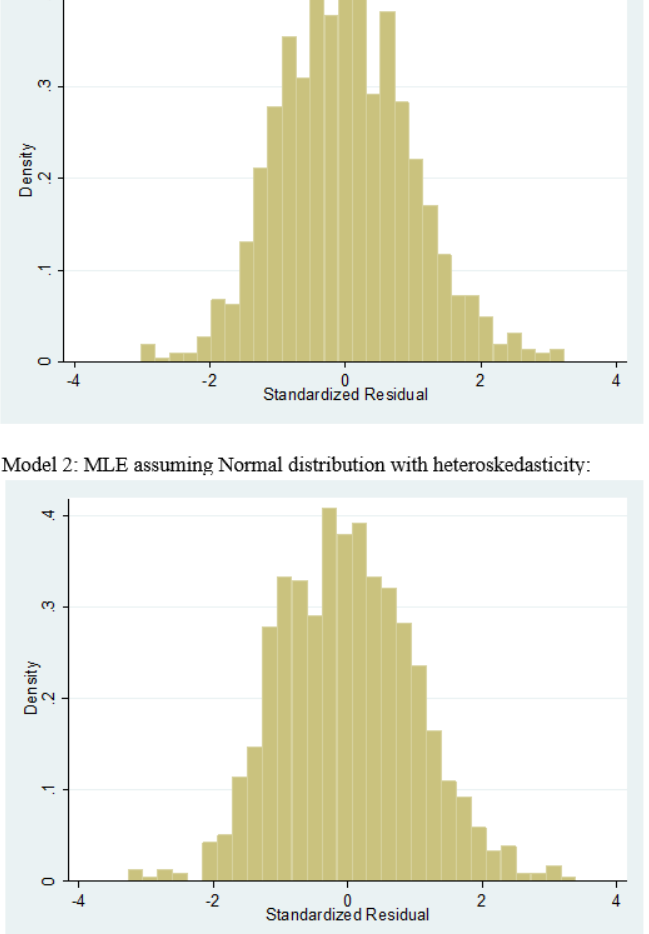
Figure A2. Histogram of the Standardized Residual from the Model for Annual Total Expenditures on Office- Based